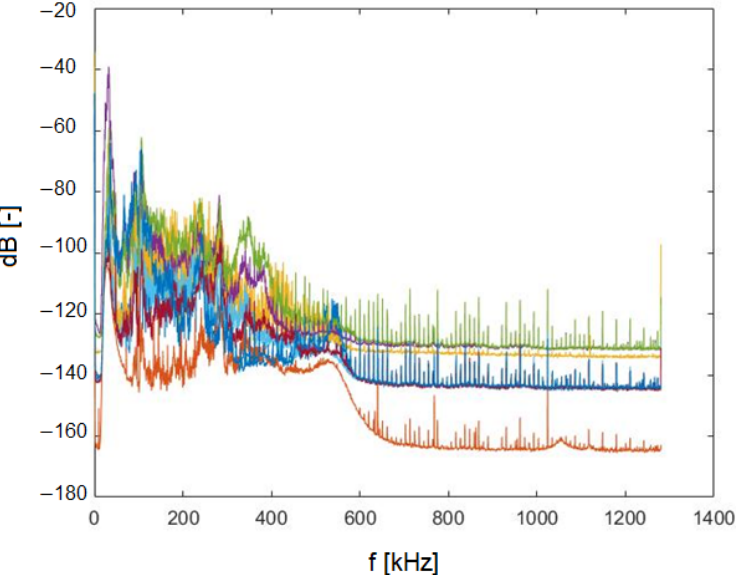
Figure 3. Example of collective frequency analysis of AE signals registered for particular analyzed classes of PDs.